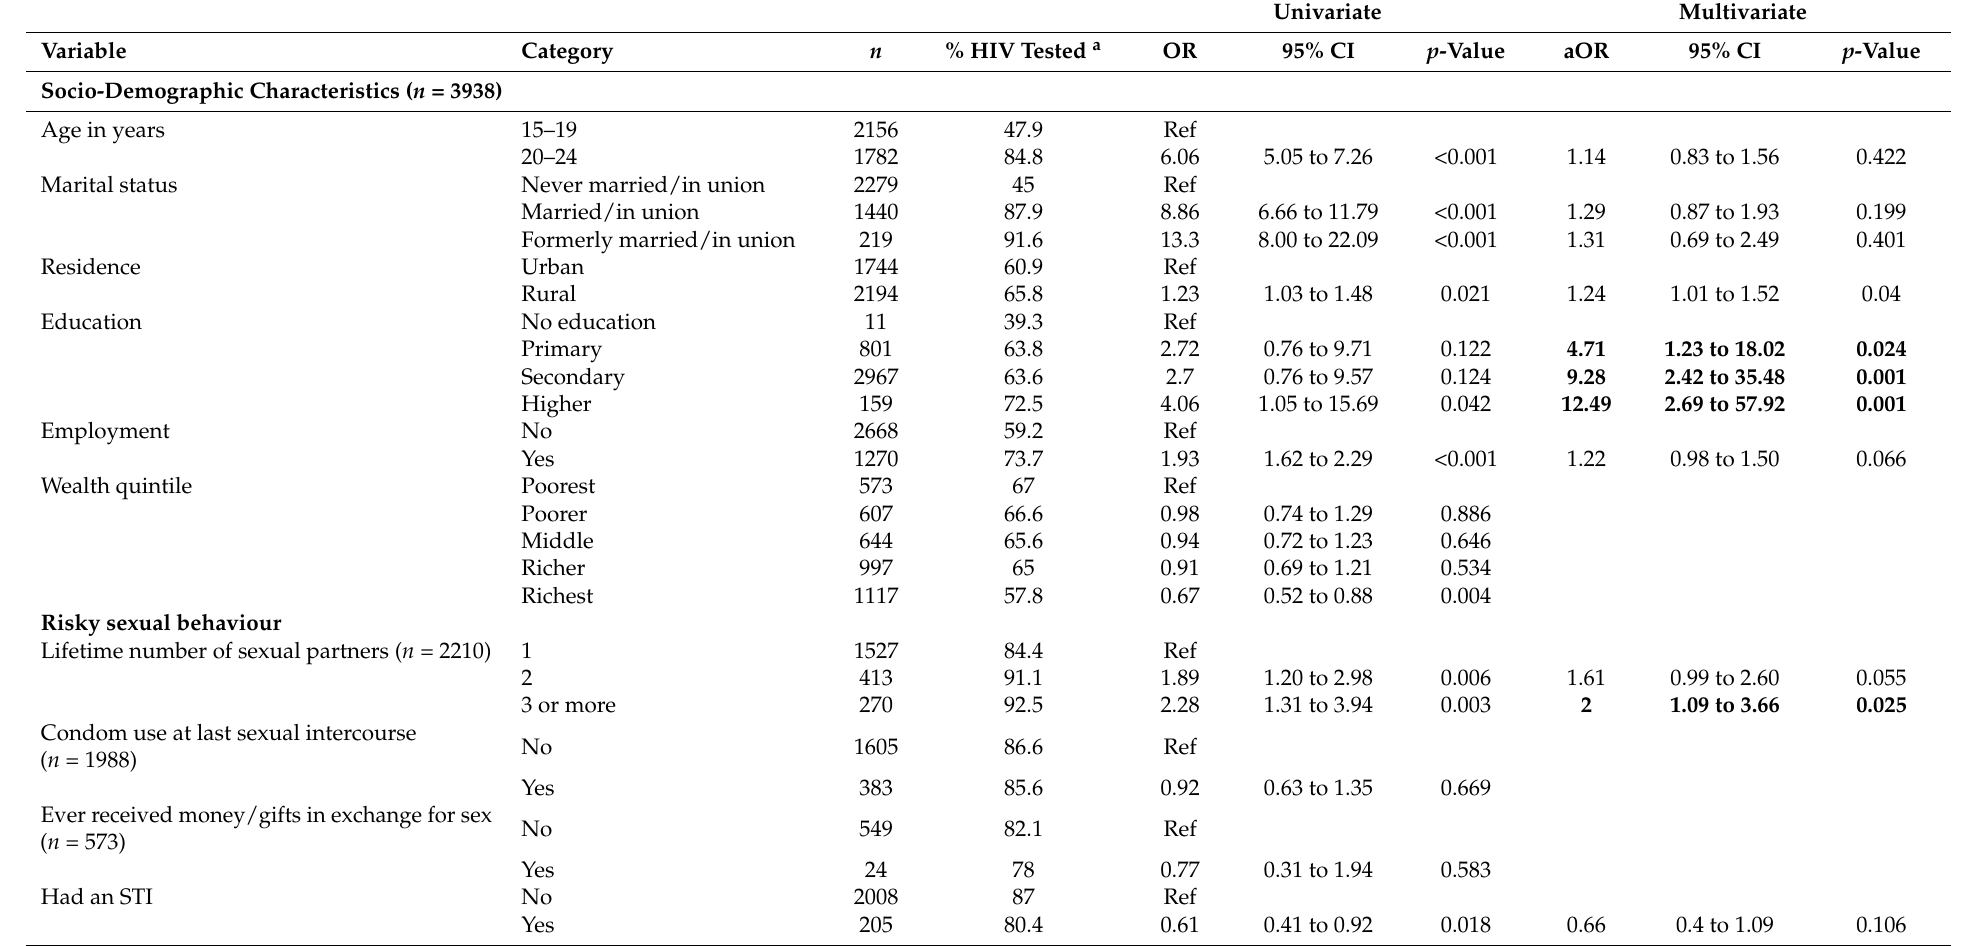
Table 2. Factors associated with HIV testing among adolescent girls and young women who participated in the 2015 Zimbabwe DHS. Univariate